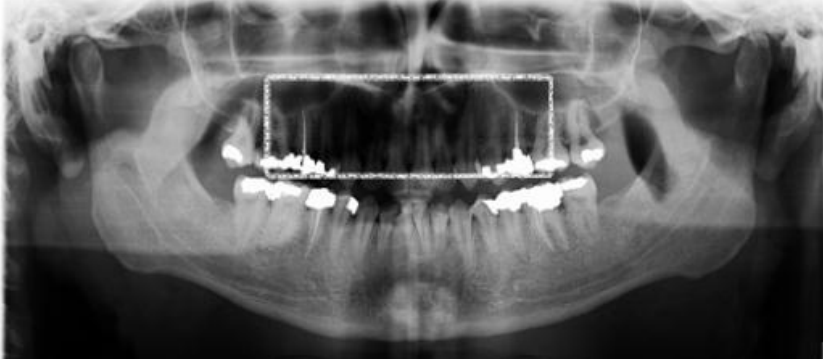
Figure 1. An example of a panoramic radiograph with a positioning error (The area depicted by the